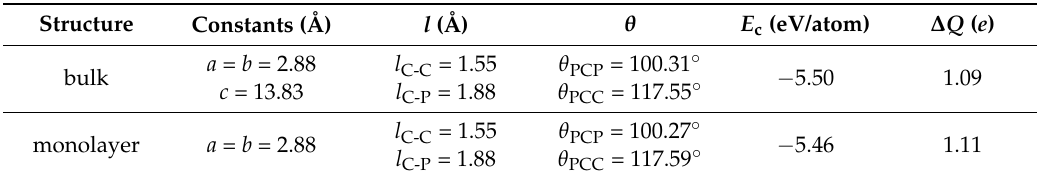
Table 1. Structural parameters of GaSe-like bulk and 2D phosphorus carbide (PC), the cohesive energy E c , and charge transfer ∆ Q from P atom to C atoms. a , b , and c represent the lattice constants, l is the bond length and θ is the bond